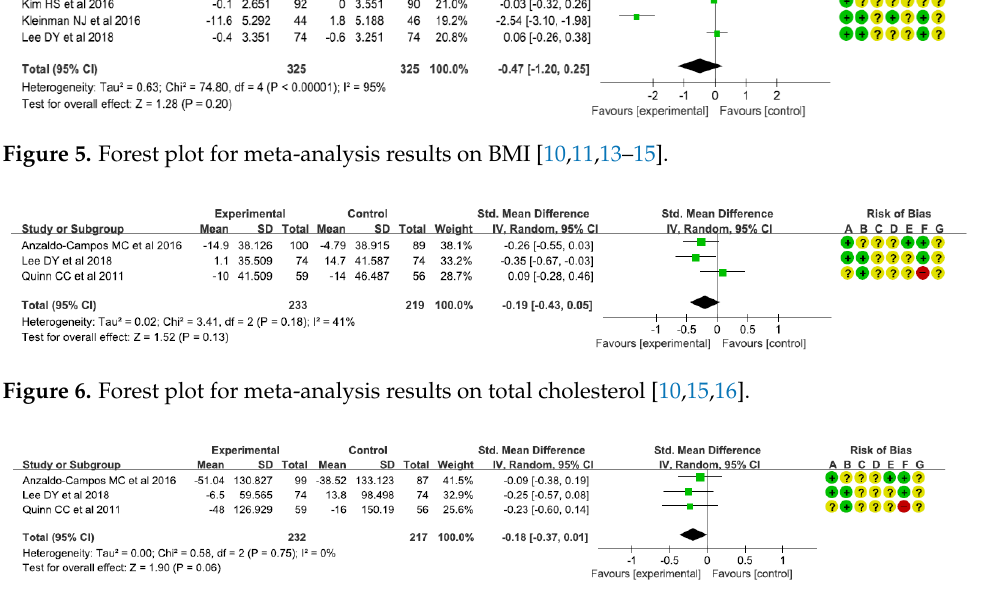
Figure 7. Forest plot for meta-analysis results on triglyceride [10,15,16].